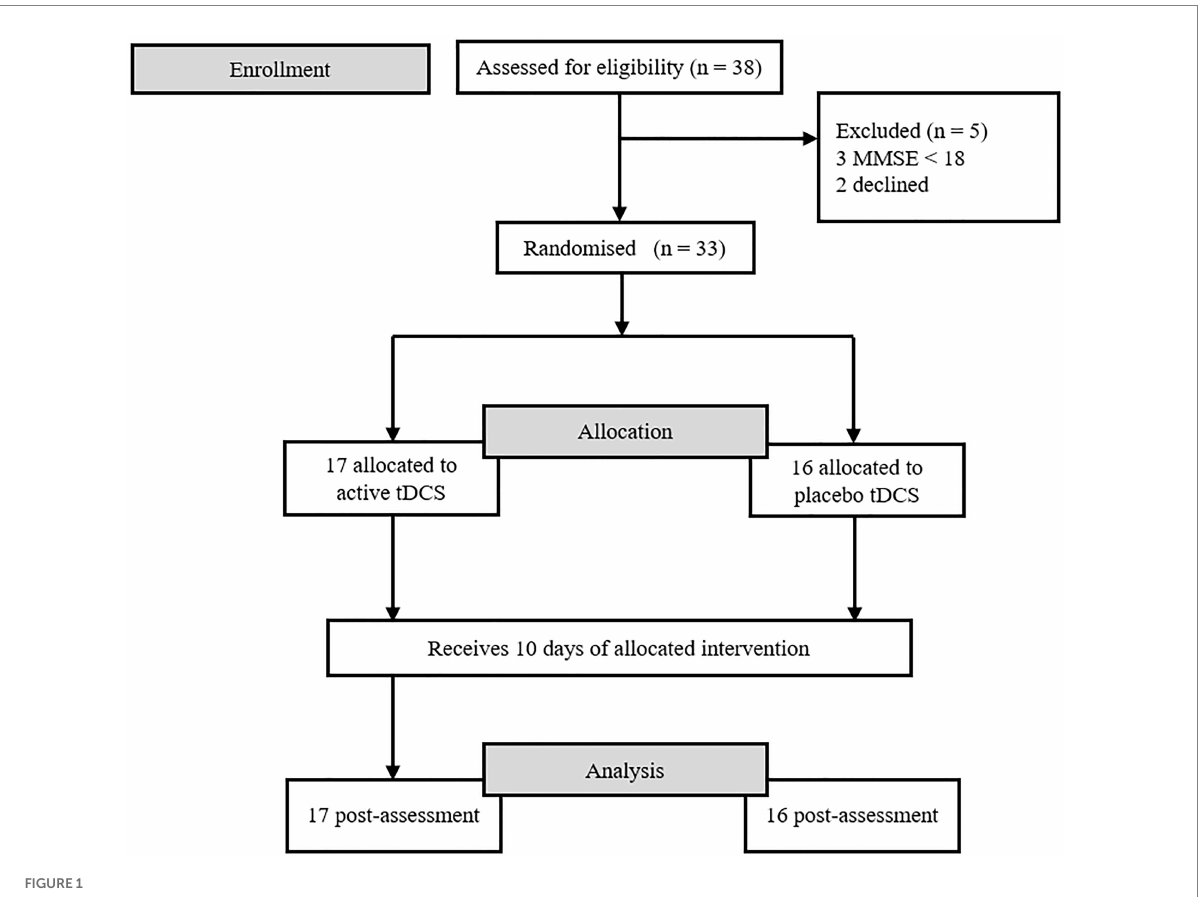
FIGURE 1 Flow diagram of trial